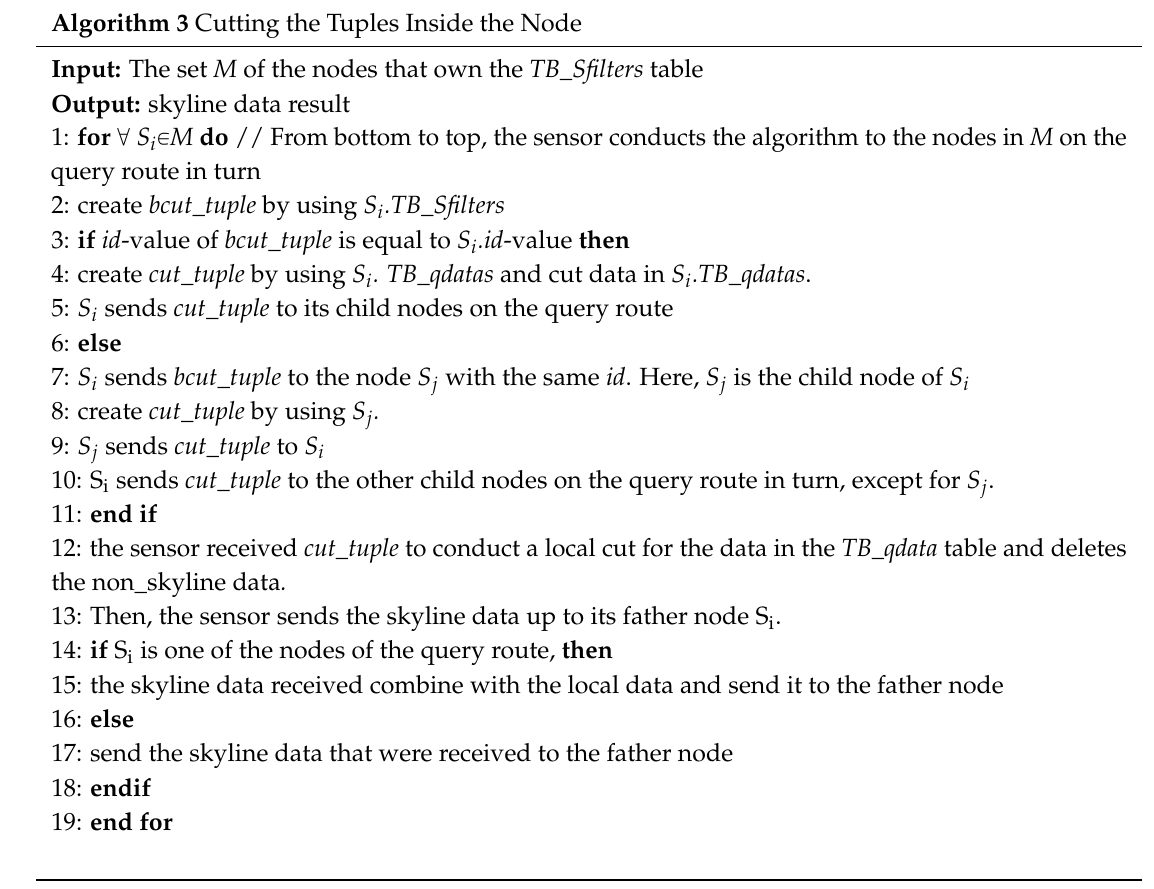
Algorithm 3 Cutting the Tuples Inside the